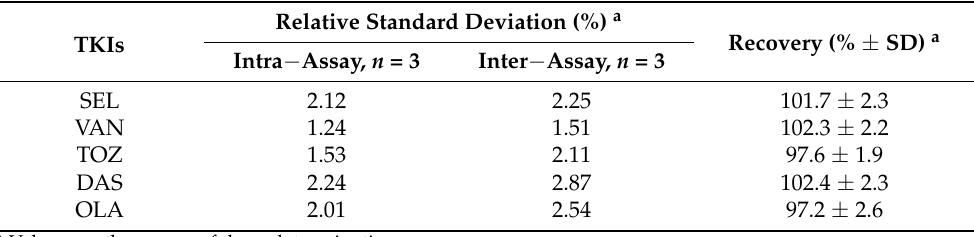
Table 6. Precision and accuracy of the proposed 96-microwell spectrophotometric assay for TKIs via their CT reactions with CLA.